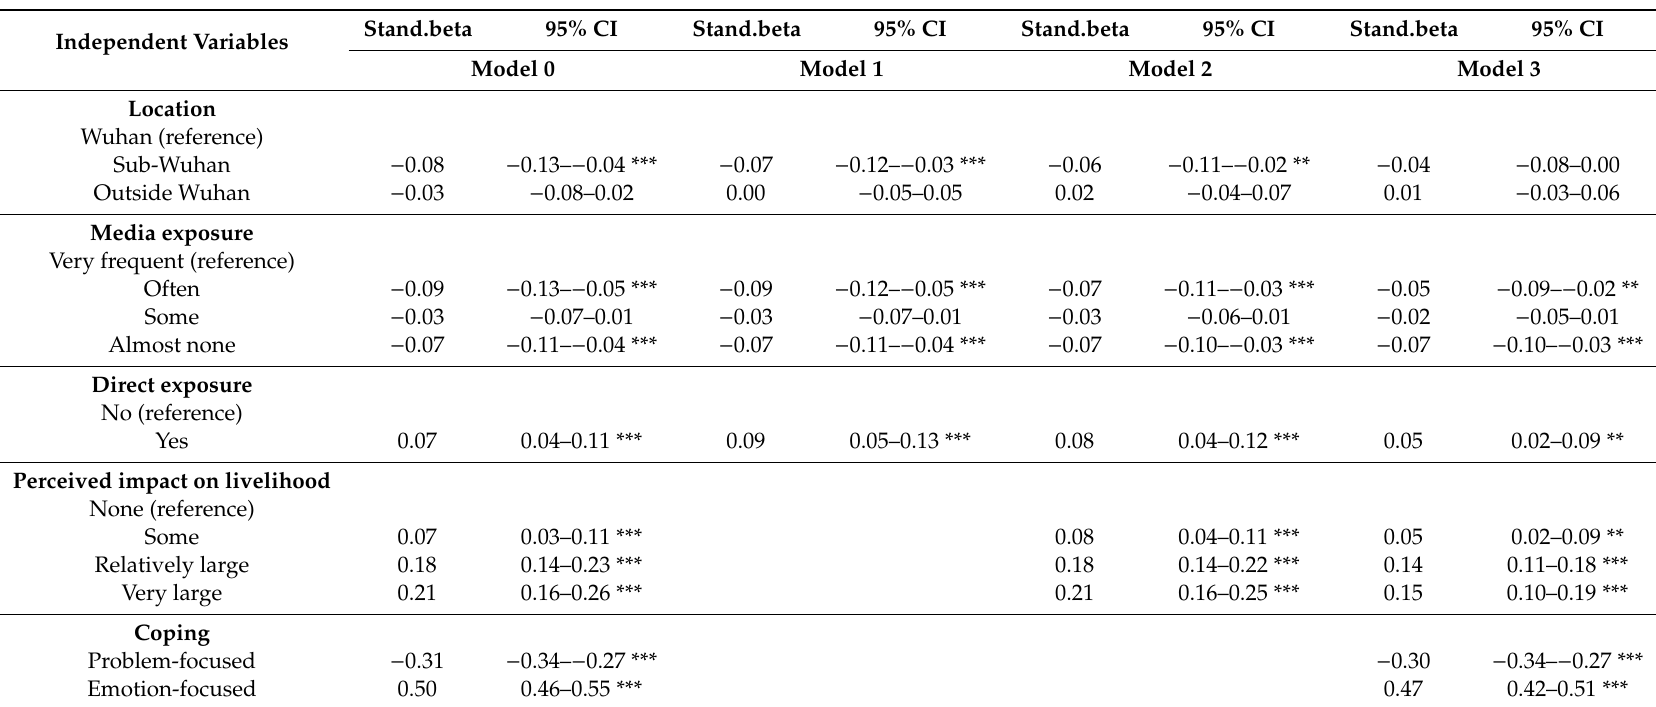
Table 2. Multiple linear regressions with exposure and coping style predicting mental health